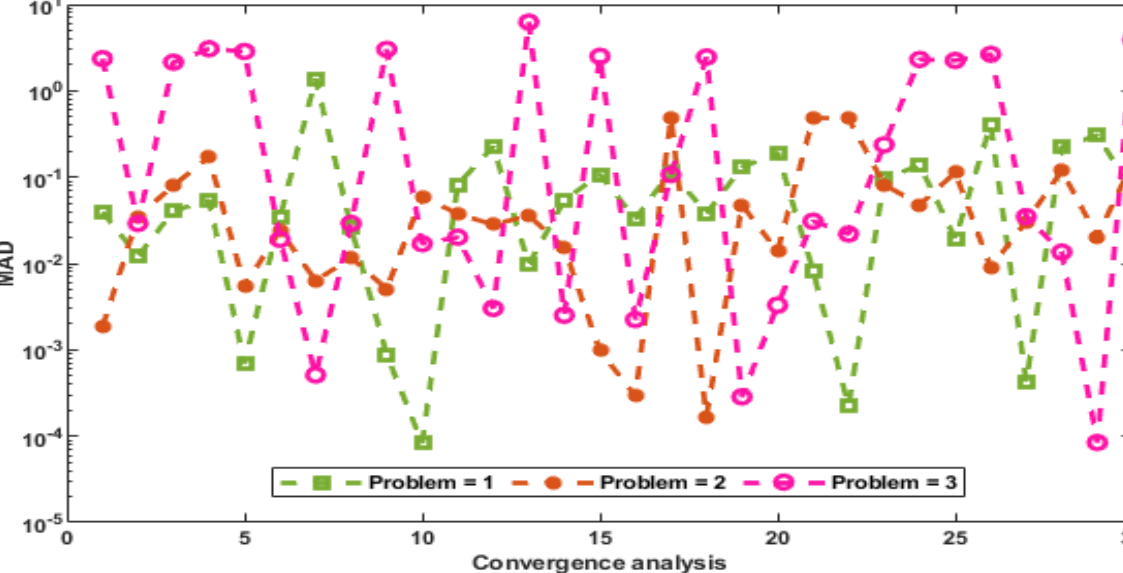
Figure 5. Convergence performance of MAD for each problem of the HO-NSDM.